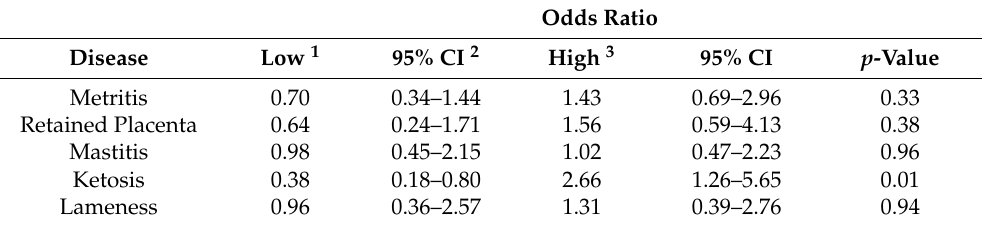
Table 2. Comparisons of odd ratios between low SCC and high SCC cows that were diagnosed with post-partum